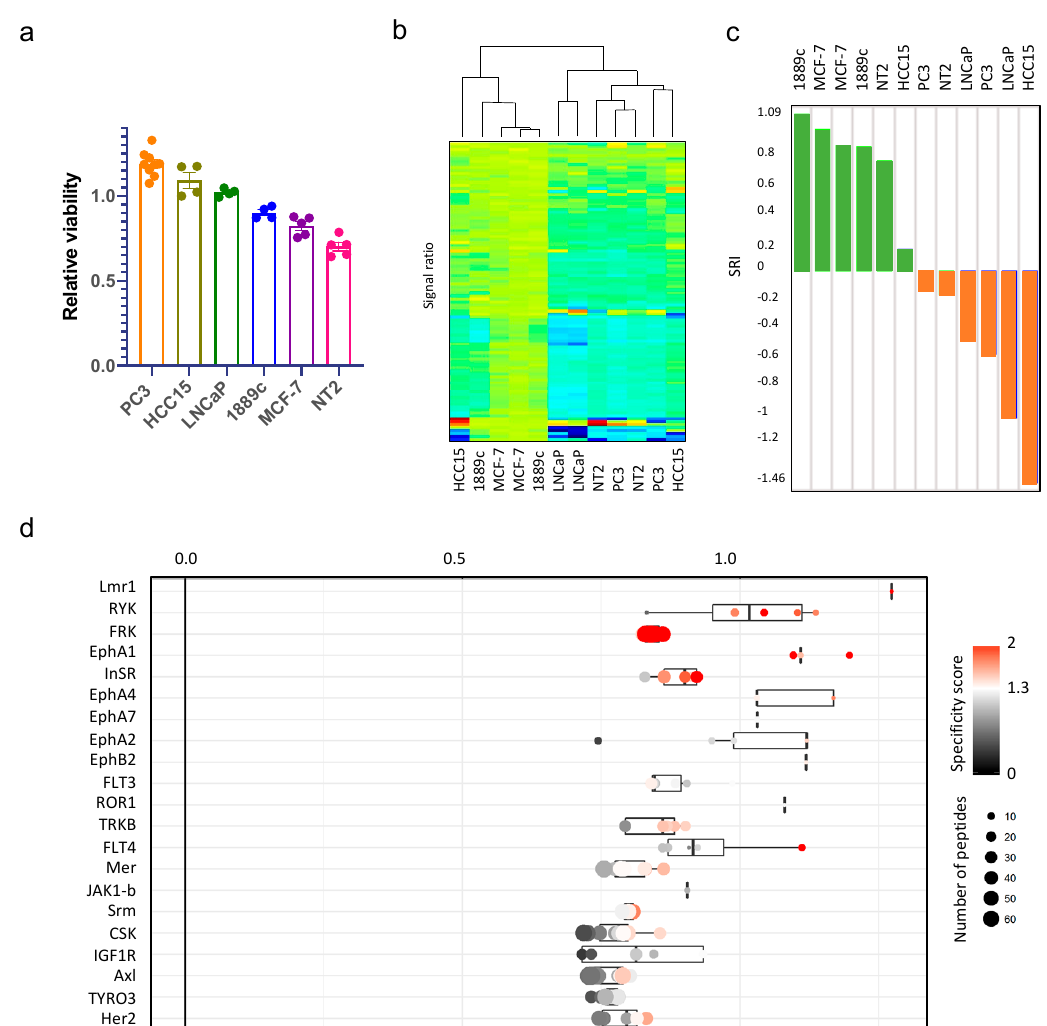
Figure 1. Generation of the SRI using six cell lines with different sunitinib responses. ( a ) Relative cell viability of PC3, HCC15, LNCaP, 1889c, MCF-7, and NT2 compared to untreated control after sunitinib treatment (5 µM) for 48 h. ( b ) Unsupervised hierarchical clustering of phosphorylation ratios of cell lines (sunitinib treated vs. untreated). ( c ) Waterfall plot of sunitinib-sensitive and resistant cell lines based on their SRI established by PLS-DA. Green = responding SRI, orange = resistant SRI. ( d ) Prediction of upstream tyrosine kinases responsible for sunitinib resistance. The value on the x-axis indicates the activity change of each kinase relative to untreated control. The color indicates the reliability of the prediction (specificity score). The dot size indicates the number of phosphorylated peptides on which the prediction was based.